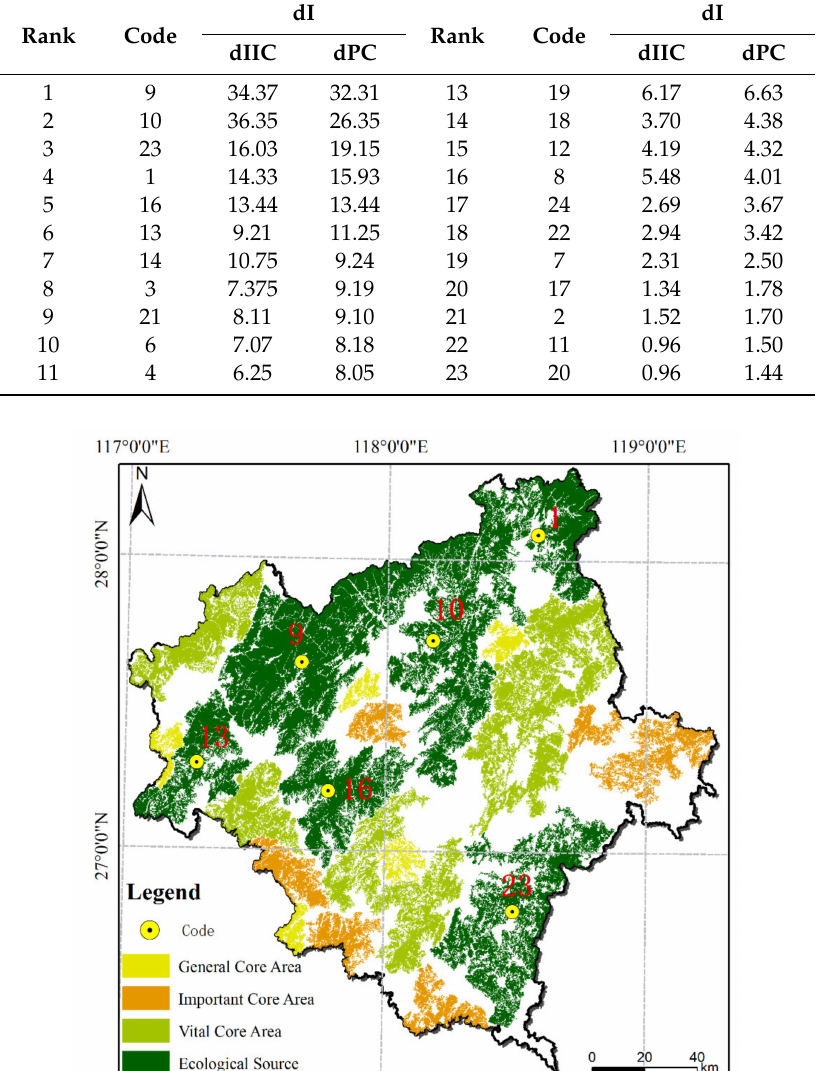
Figure 3. Classification of the core area based on the patch